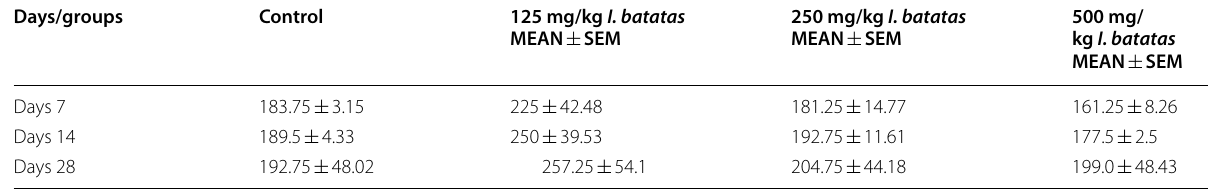
Values are mean